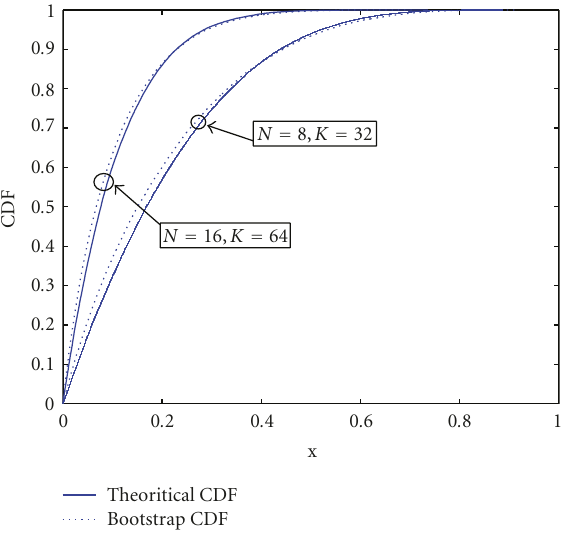
Figure 3: Test statistic versus range in K -distributed homogeneous clutter, where ν = 0 . 1, μ = 1, N = 8, K = 32, N it = 1, and P e = 0 . 025.